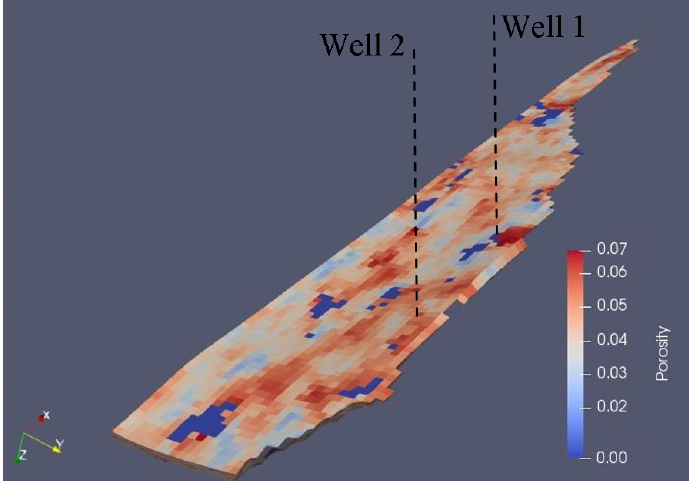
Figure 16. Field porosity distribution.